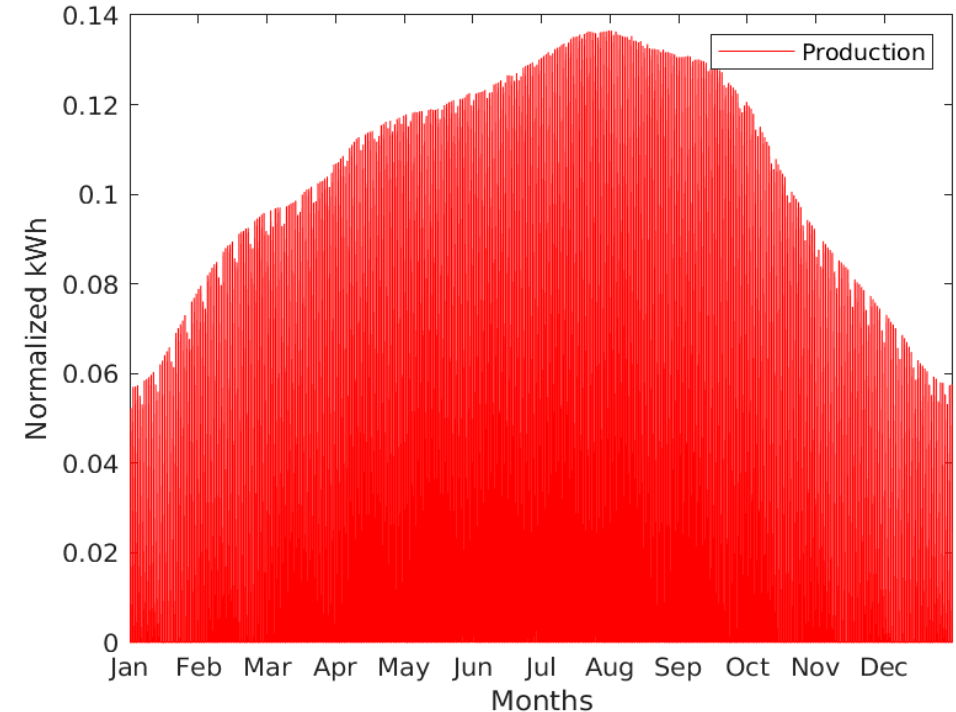
Figure 3. Normalized production for UPAC class C [39].